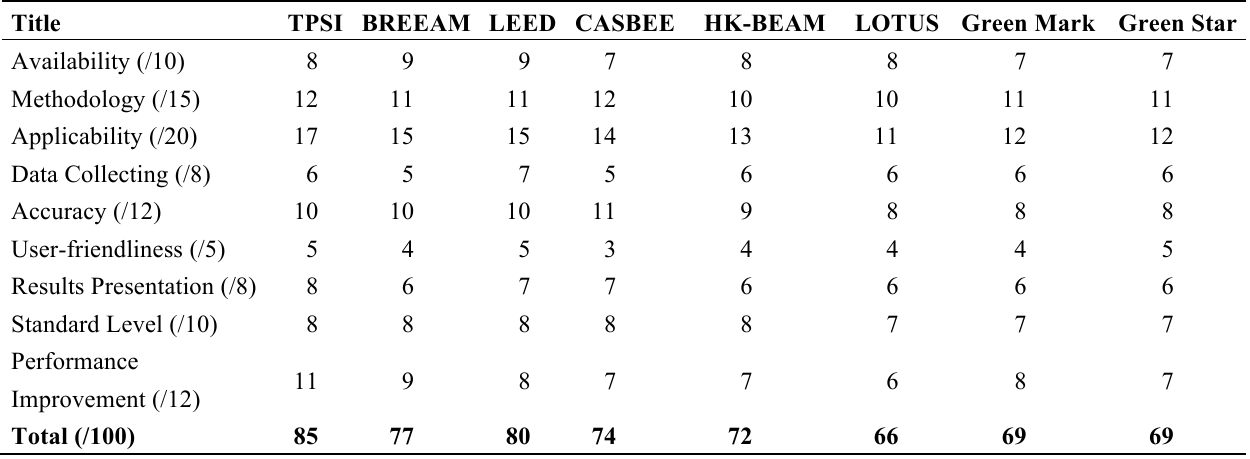
Table 5. Points achieved by rating systems as a result of the Interview